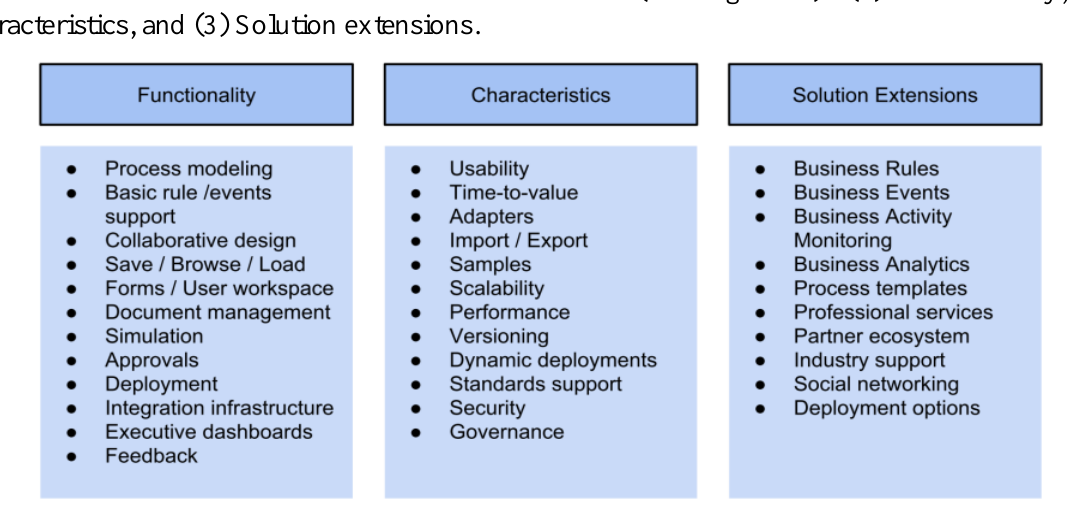
Figure 2. Frame of reference by Lustratus